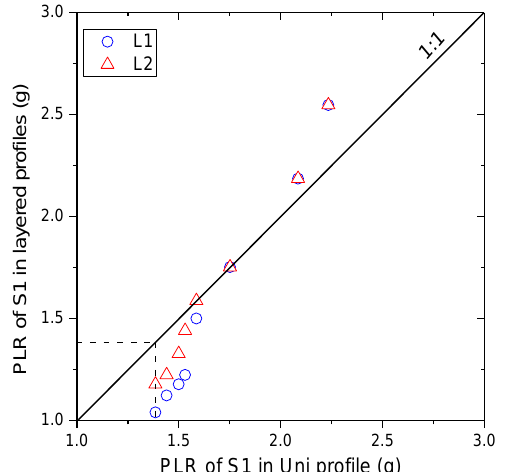
Figure 7. Comparison of period lengthening ratio (PLR) for the S1 structure on L1 and L2 profiles to those on Uni profile. those on Uni